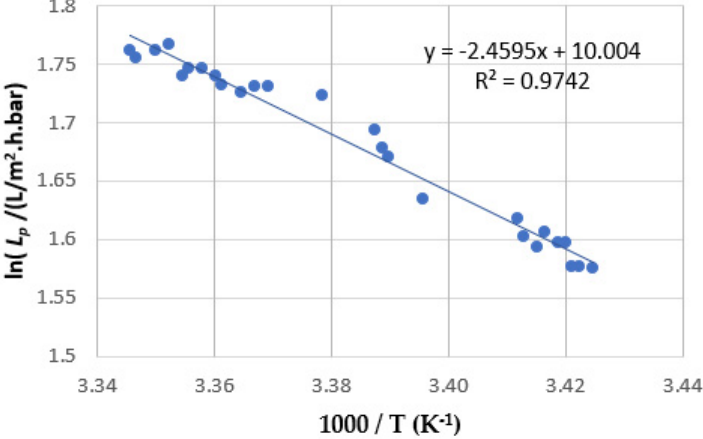
Figure 4. Determination of the membrane permeability temperature adjustment factor for ULP-2540 membrane (P = 5 bar, distilled water) .